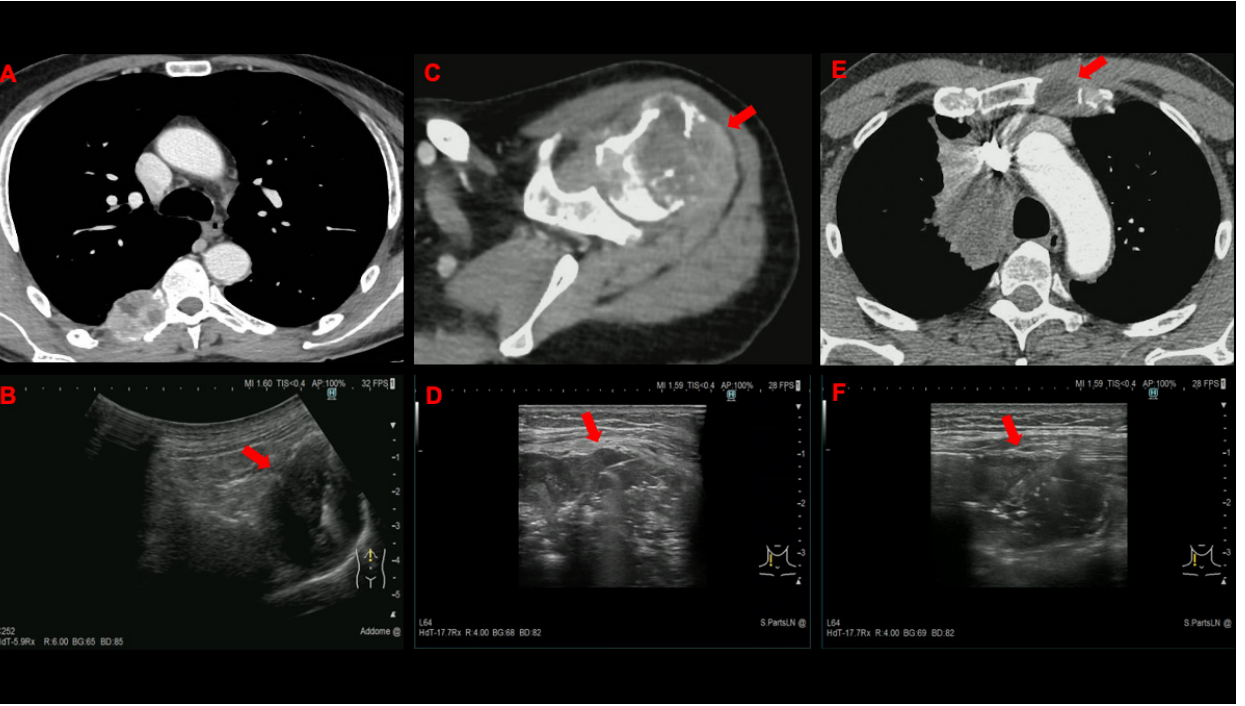
Figure 3. Contrast-enhanced CT and corresponding US-NAB image of US-NAB (red arrow) from bone metastasis involving a rib and a transvers process of a thoracic vertebra ( A , B ), the right homer ( C , D ), and the sternum ( E , F ). Table 2. Study